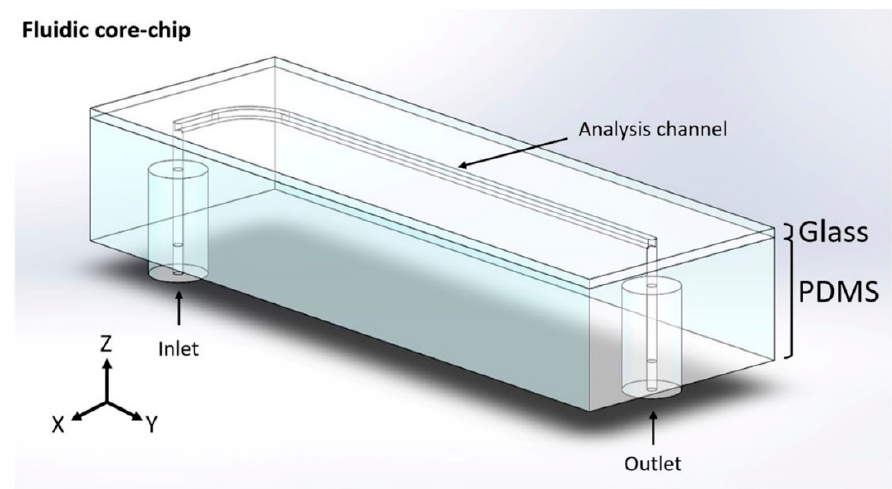
Figure 2. CAD design of the fluidic core-chip.